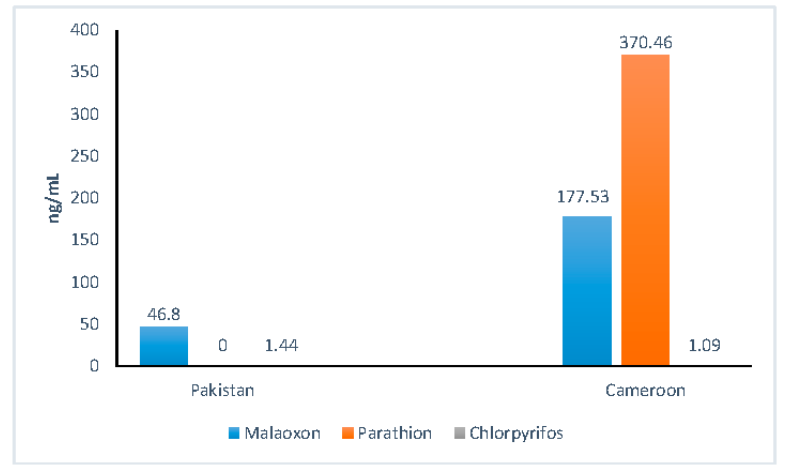
Figure 1. Distribution of blood pesticides levels in Pakistani and Cameroonian groups.